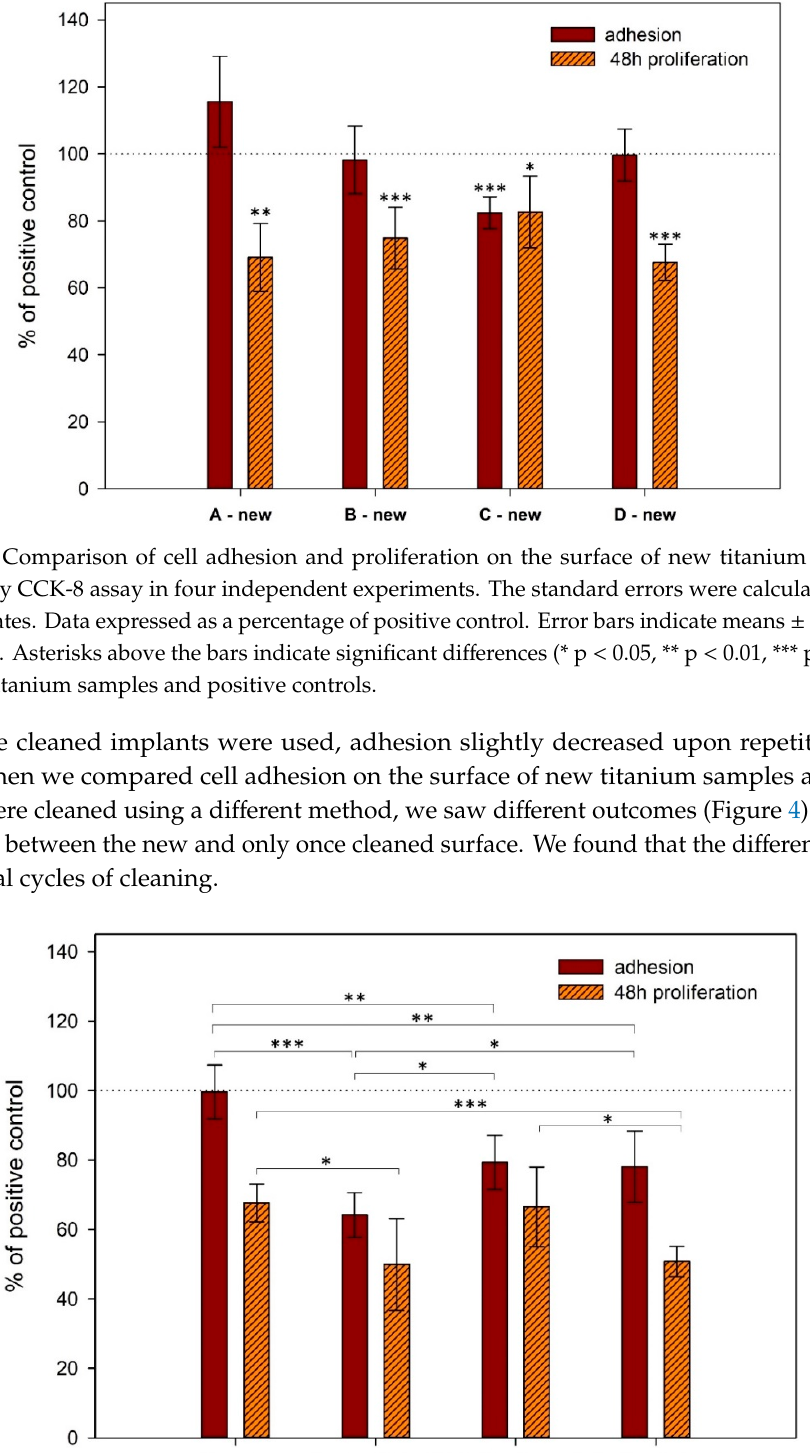
Figure 4. Comparison of cell adhesion and proliferation on the surface of new and different times cleaned same titanium samples assessed by CCK-8 assay. The standard errors were calculated from five replicates. Data expressed as a percentage of positive control. Error bars indicate means ± standard deviations. Asterisks represent statistical significance between respective groups (* p < 0.05, ** p < 0.01, *** p < 0.001).